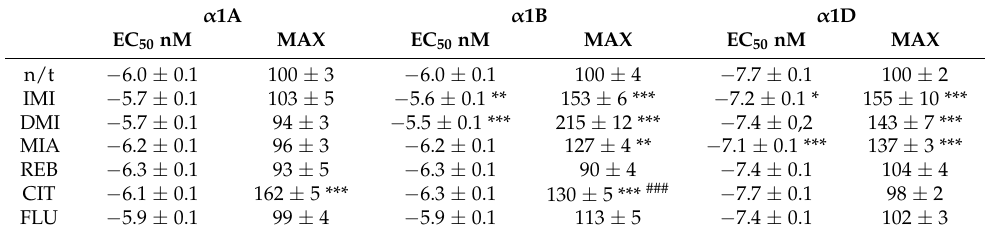
Table 3. Effects of 120 h preincubation with the chosen antidepressants on the EC 50 and the maximal response (MAX) of the second messengers to noradrenaline for the α 1A-, α 1B- and α 1D-adrenergic receptor subtypes. n/t—nontreated control; IMI—imipramine; DMI—desipramine; MIA—mianserin; REB—reboxetine; CIT—citalopram; FLU—fluoxetine. * p < 0.05, ** p < 0.01, *** p < 0.001 vs. the